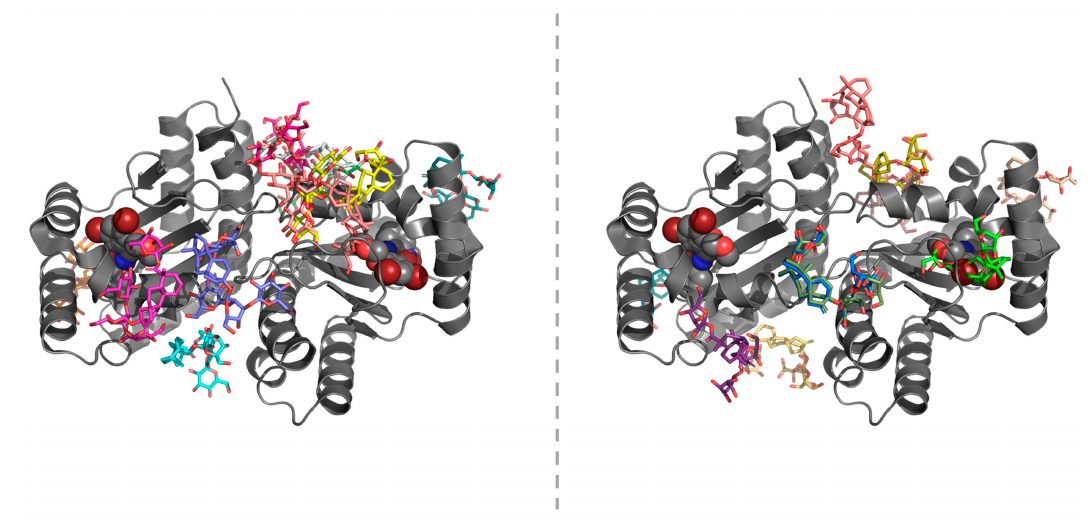
Figure 8. Representative (i.e., top-ranking) binding poses of the steviol glycosides from each cluster around the LasR LBD in the open-loop conformation. Left panel: Reb A. Right panel: stevioside. Images were prepared using the PyMOL Molecular Graphics System, version 1.8 (Schrödinger LLC, Portland, OR, USA).